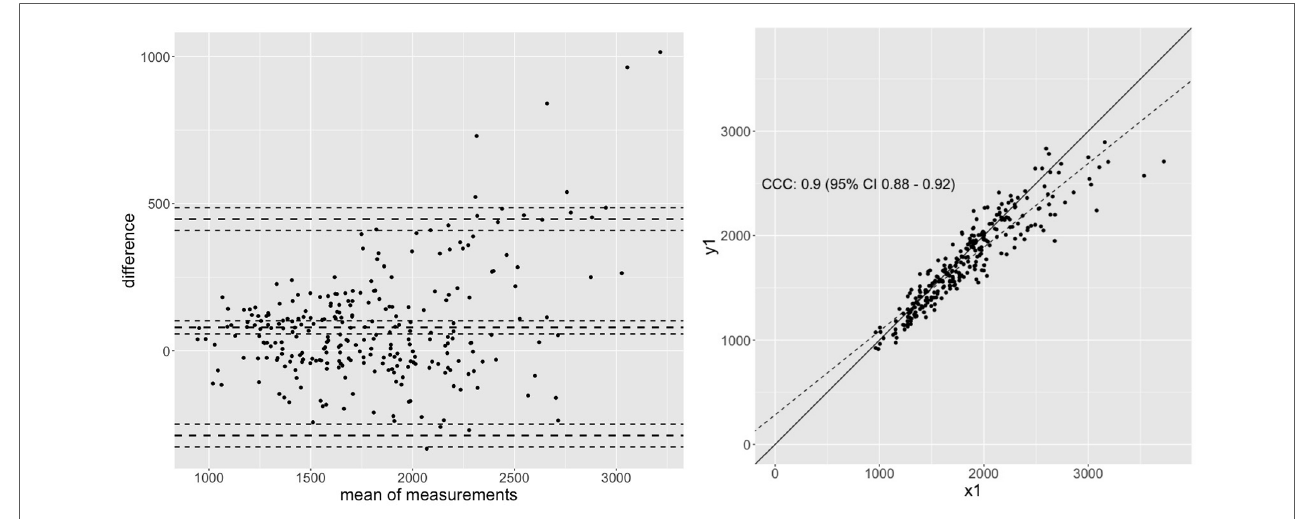
FIGURE 1 An exemplary dataset to calculate the concordance correlation coef fi cient (CCC) of 0.9 with n =273 showing high Pearson correlation with r =0.92, representing magnitude of correlation usually found between dynamic and isometric